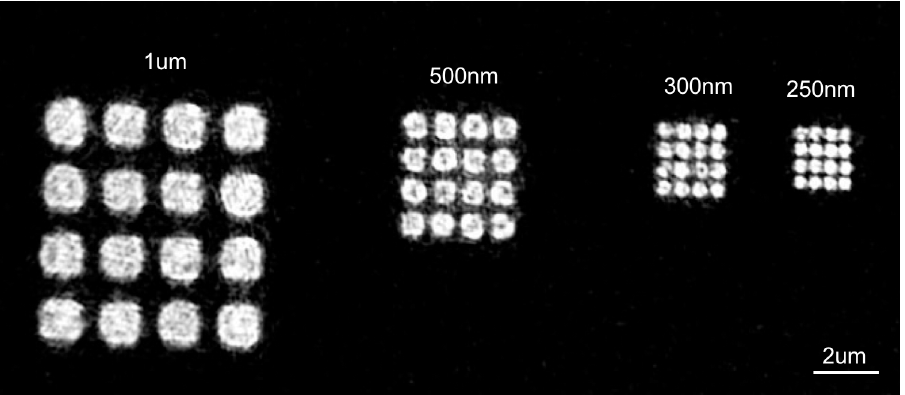
Fig 4. Nanoscale protein patterning. Submicron squares were patterned with biotin and then labeled with strep-647. From left to right the squares have 1 μm, 500 nm, 300 nm and 250 nm sides, respectively; 250 nm is the resolution limit of the lithography tool. The inhomogeneity of fluorescent signal was most likely caused by the nature of super- resolution fluorescent